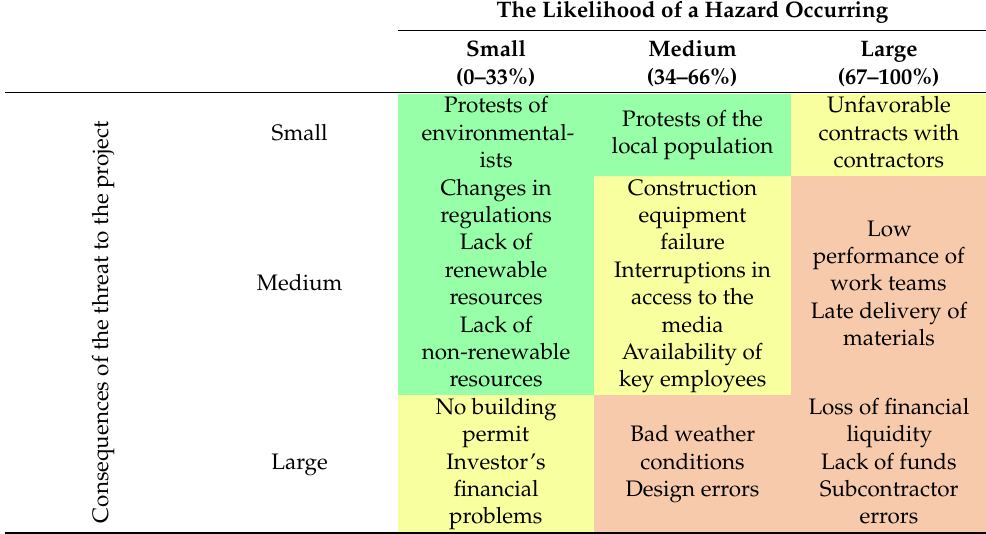
Table 1. Sample risk matrix of a construction project